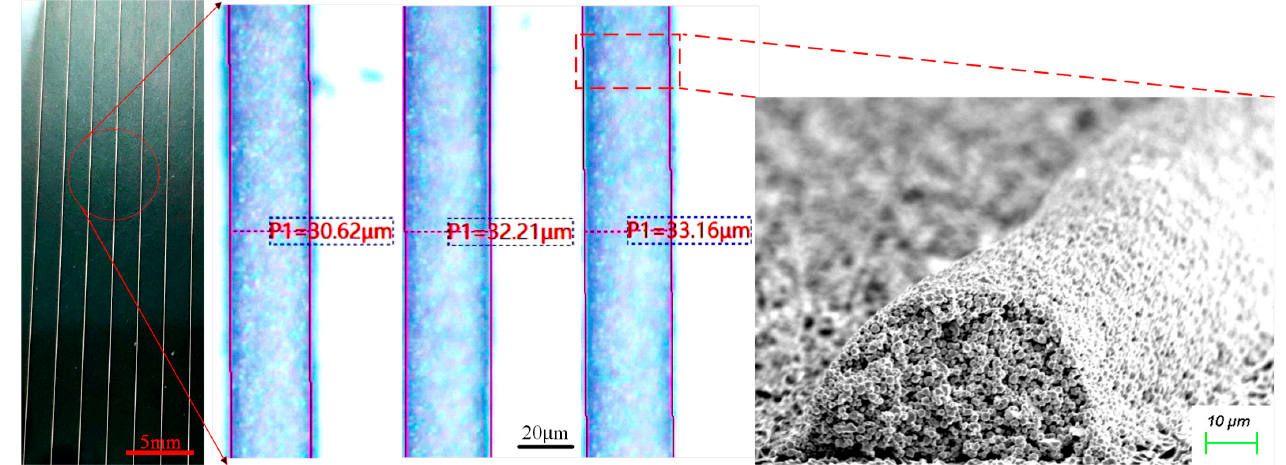
Figure 9. Macro picture and microscopic magnification of the results of the optimal printing param- eters.